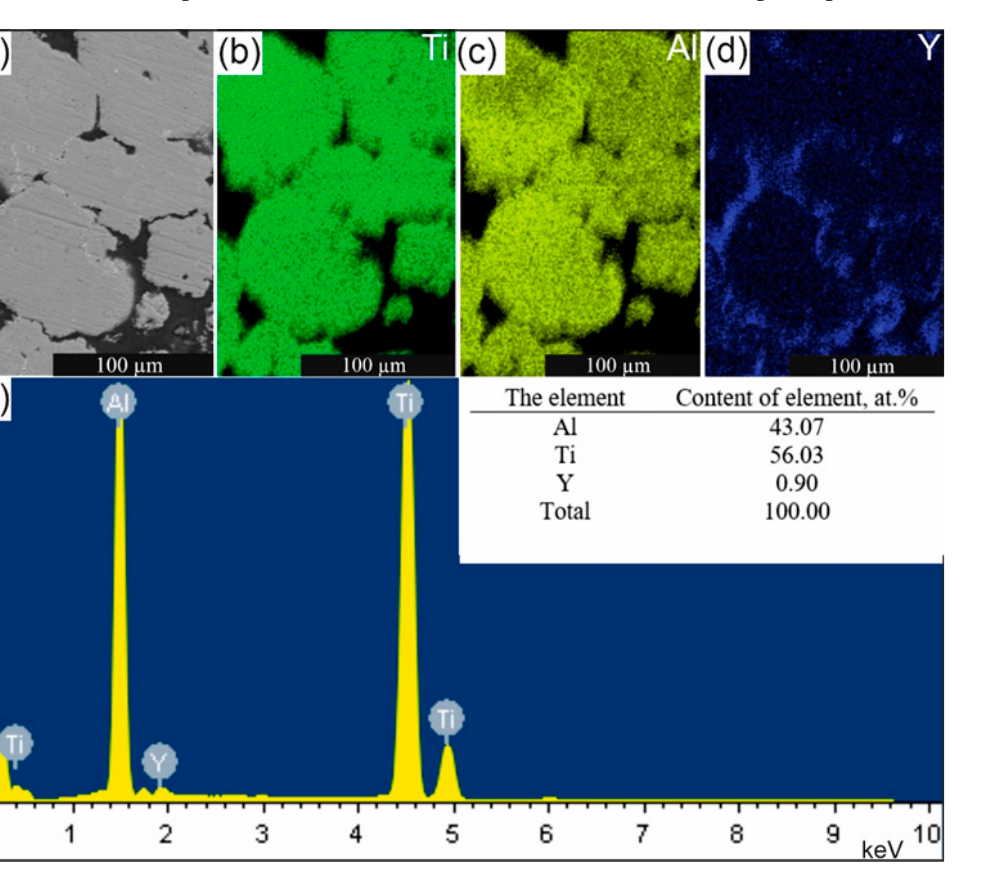
Figure 2. SEM images of the Ti-Al-Y alloy ( a ) with the super-spectral surface ( b – d ) and with the energy-dispersive spectral X-ray analysis (EDX) spectrum of relevant regions ( e ).